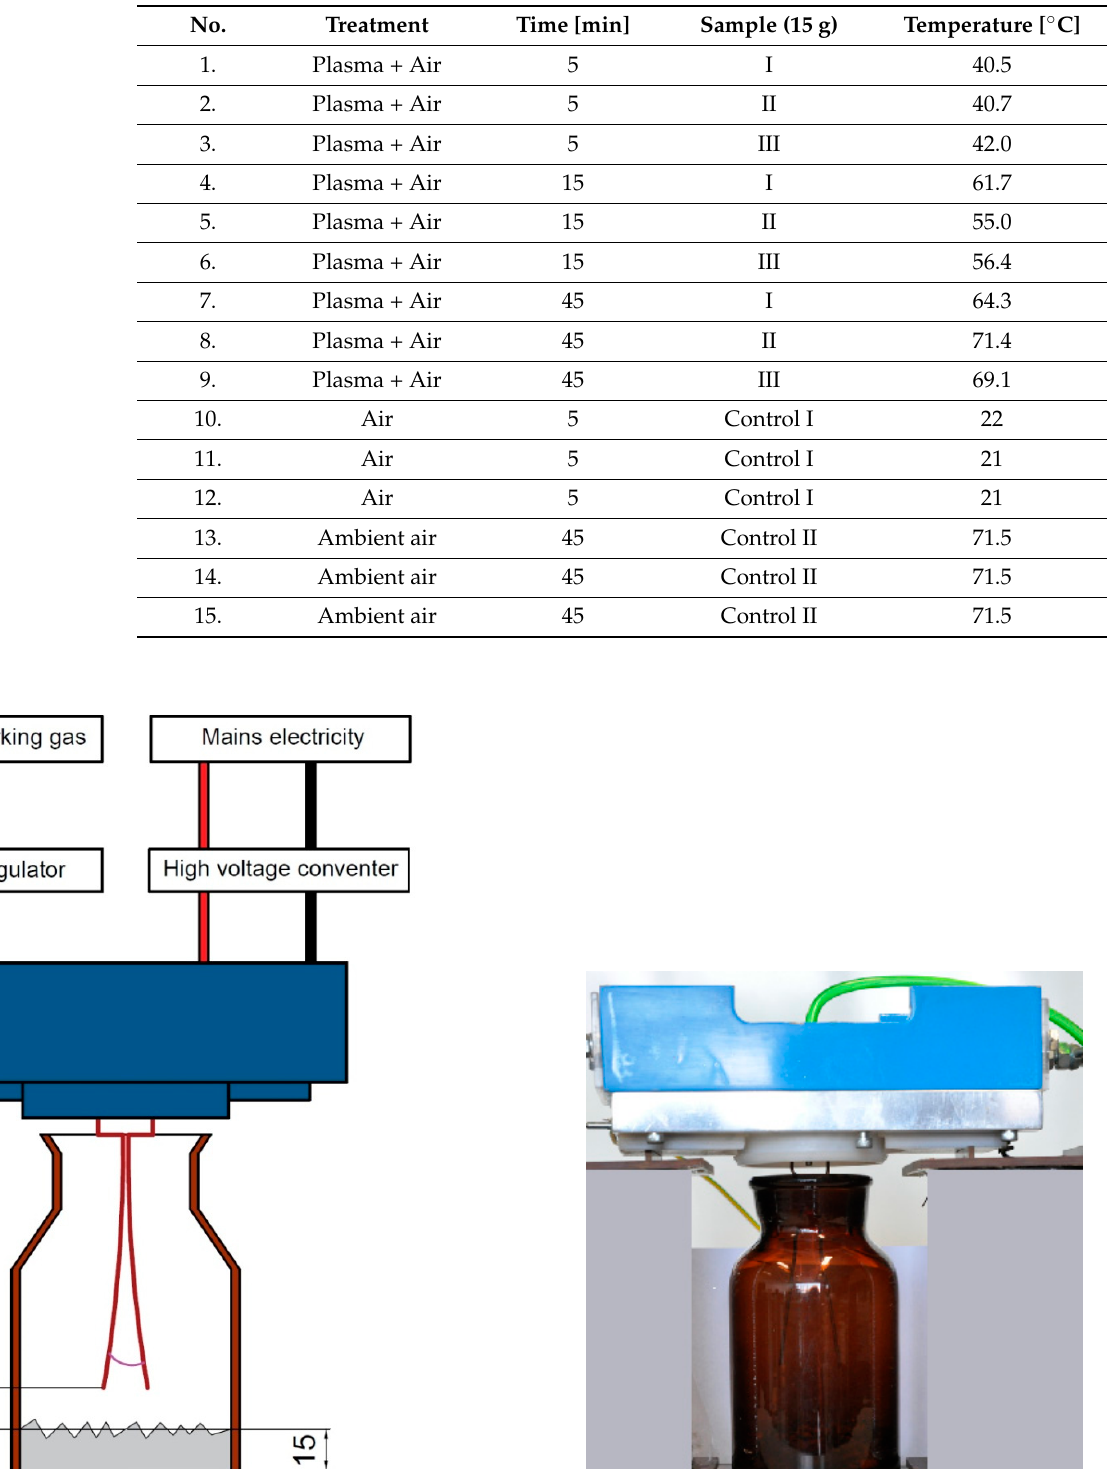
Table 2. Sample temperatures for the selected experiment condition and duration.